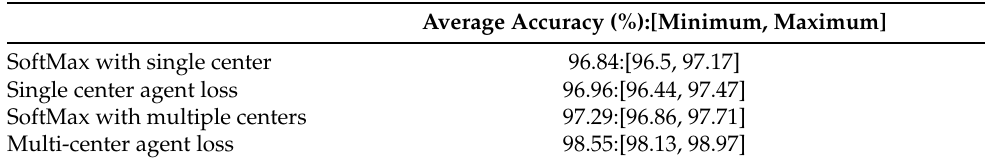
Table 2. Ablation study of multi-center agent loss on CNSID100 with 50% individuals